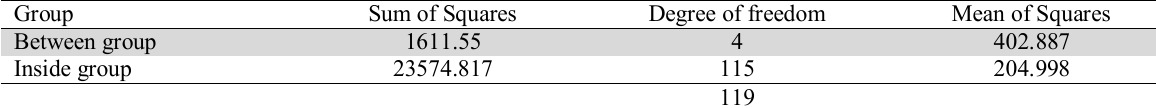
The summary of ANOVA for testing the effect of employment type Group Sum of Squares Degree of freedom Mean of Squares Between group 1611.55 Inside group 23574.817 F-value = 1.965 Sig. =